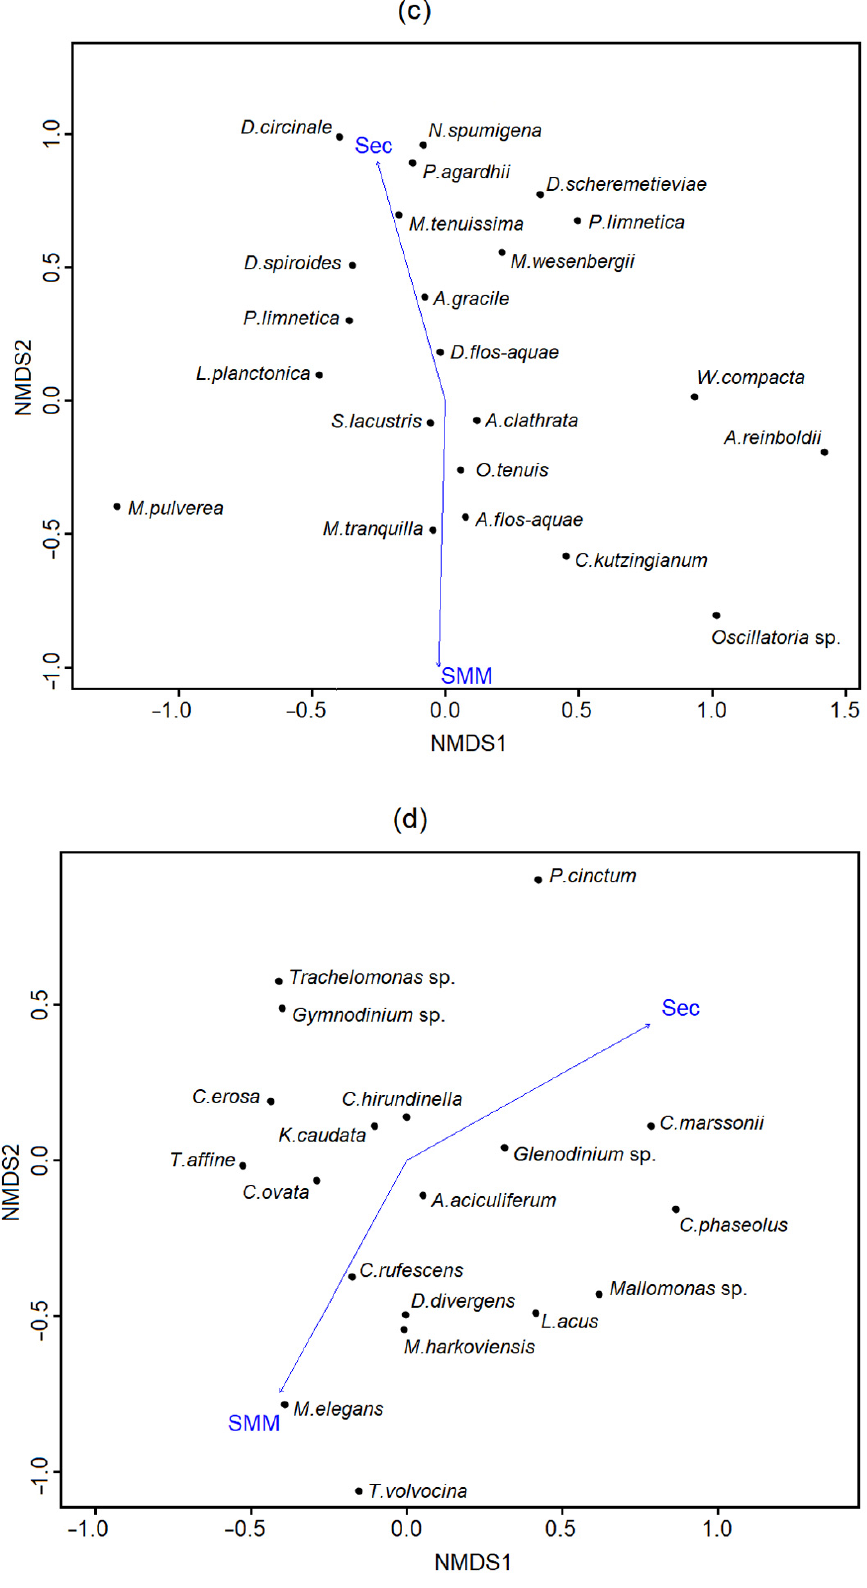
Figure 6. Phytoplankton biomass vectors based on NMDS results and environmental variables, water transparency [Sec, m], and concentrations of suspended particulate mineral matter [SMM, g m − 3 ] in the Neva Estuary in 2003–2020. Plot ( a ): Bacillariophyceae; plot ( b ): Chlorophyceae; plot ( c ): Cyanophyceae; and plot ( d ): Dinophyceae, Cryptophyceae, Chrysophyceae, Euglenophyceae, and